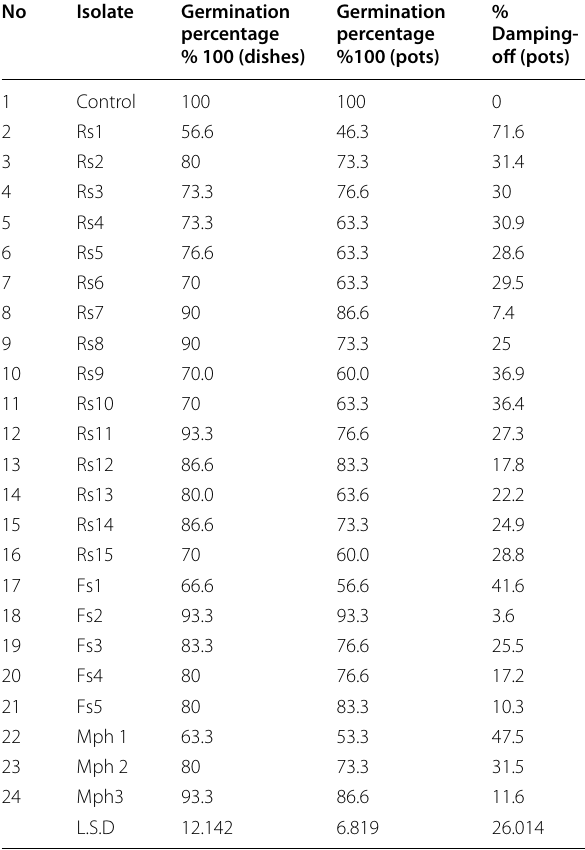
of wheat in plates and pots